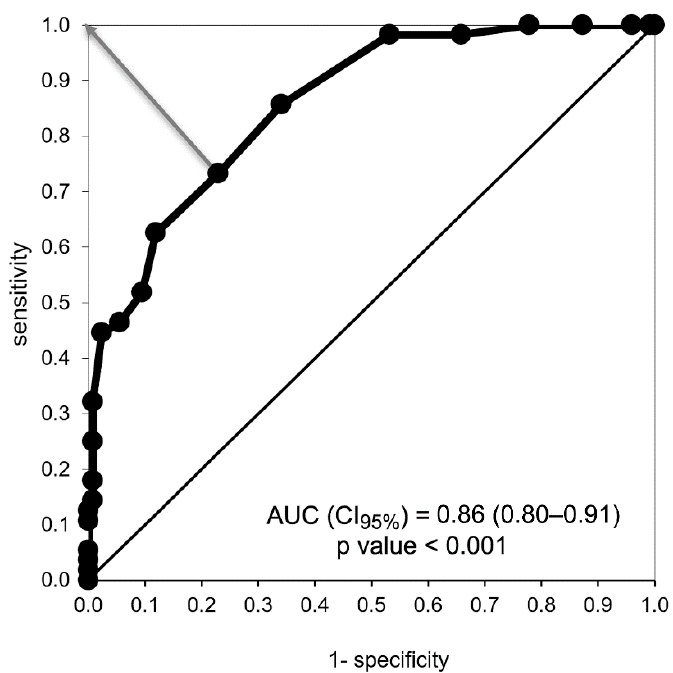
Figure 2. Receiver operator characteristic (ROC) curve analysis of the total appetite score to determine the optimum cut-off value for low appetite. An answer of “poor”, “very poor”, or “regular” appetite in the ADAT question was considered as the reference value. The best value to identify those with low appetite was a total appetite score ≤ 25 points, with a sensitivity of 73%, specificity of 77%, and an orthogonal distance of 0.35 to the optimum value (0,1). The area under the curve (AUC) score was 0.86 (0.8–0.9, CI 95%, p < 0.001)